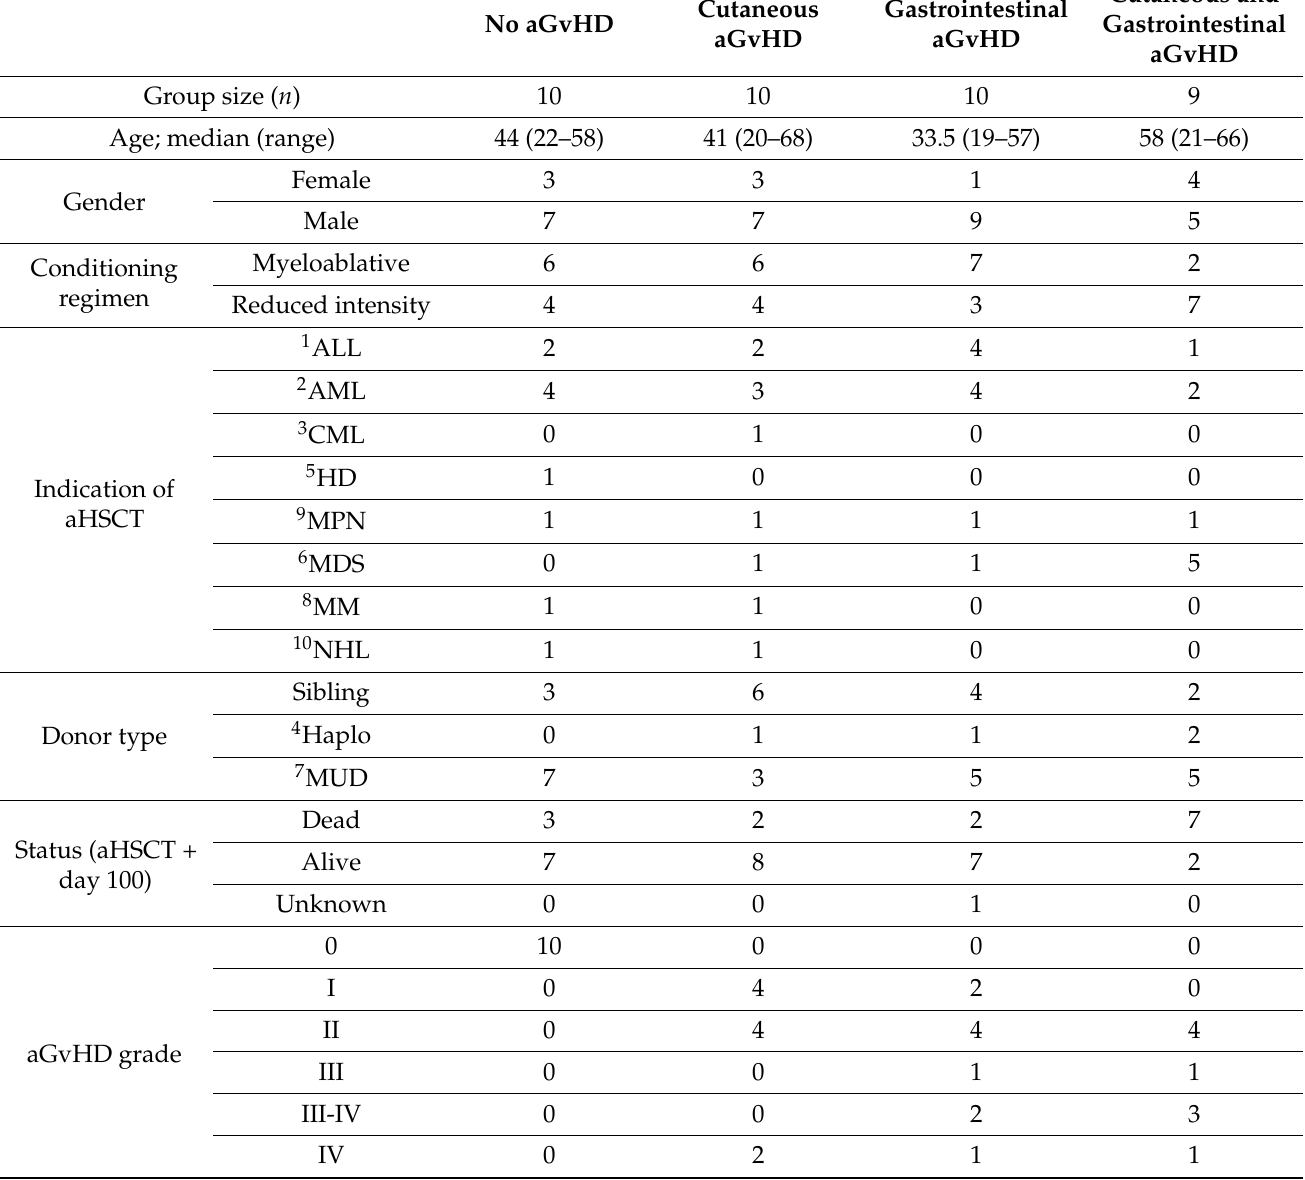
Table 1. Discovery set, summary of patient data. Summarized patient data describing the validation set according to age, gender, conditioning regimen, indication and outcome of aHSCT, donor-recipient relationship, HLA match, aGvHD developed, type and extent of organ involvement, disease severity (grade). List of abbreviations: 1 ALL, acute lymphoblastic leukemia; 2 AML, acute myeloid leukemia; 3 CML, chronic myelogenous leukemia; 4 Haplo, haploidentical donor; 5 HD, Hodgkin’s disease; 6 MDS, myelodysplastic syndrome; 7 MUD, matched unrelated donor; 8 MM, multiple